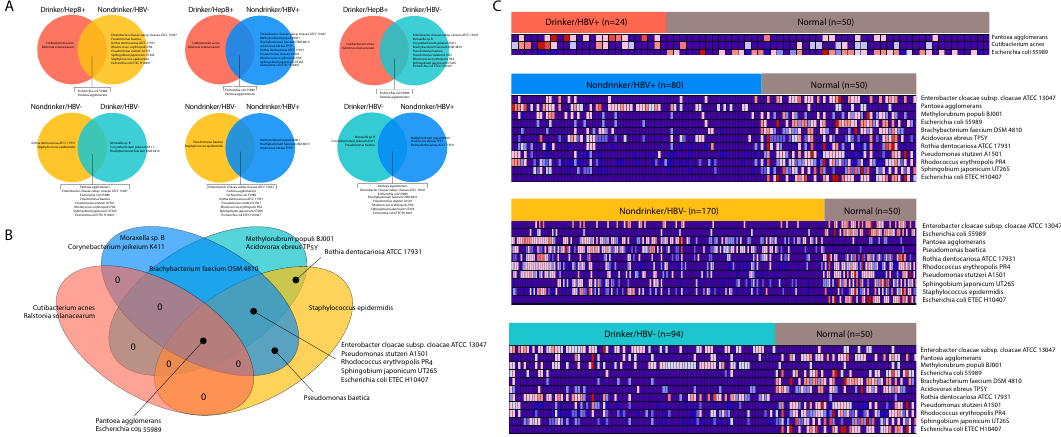
Figure 3. Di ff erential abundance of microbes between cohorts. The Kruskal–Wallis test was used to compare the abundance of microbes and determine overlapping di ff erential abundance between ( A ). two cohorts and ( B ). multiple cohorts. ( C ). Di ff erentially abundant microbe abundance visualized in cancer, versus normal comparisons for each of the four